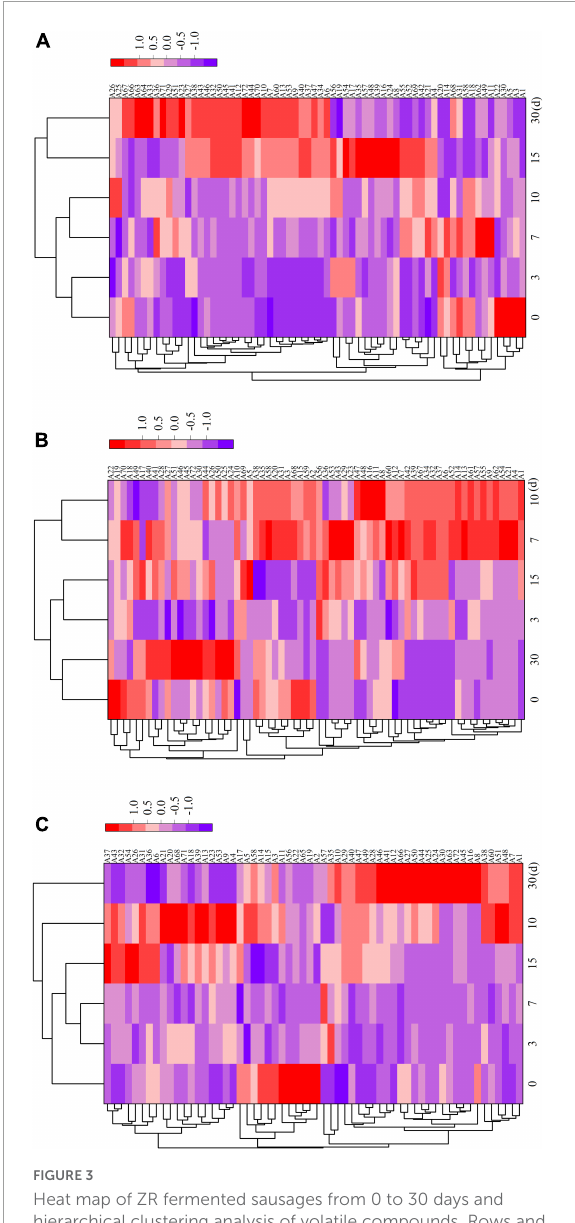
FIGURE3 Heat map of ZR fermented sausages from 0 to 30 days and hierarchical clustering analysis of volatile compounds. Rows and columns represent volatiles and time, respectively. (A) Heat map of volatile compounds in ZR, (B) heat map of volatile compounds in TR1-1-3 and (C) heat map of volatile compounds in ZF22. Blue to red shades correspond to volatiles from low to high abundance. A1–A72 are the types of